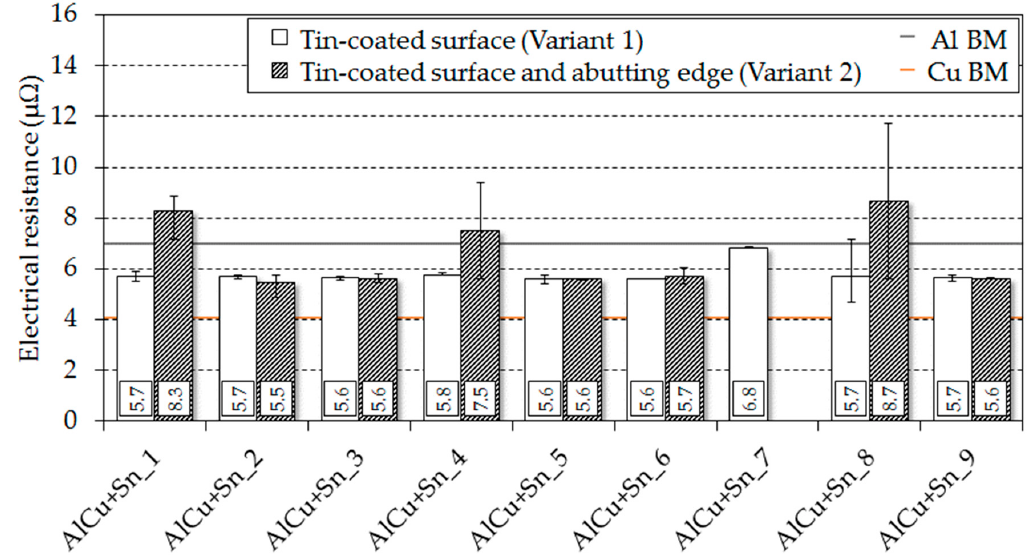
Figure 3. Results of electrical resistance measurements for the friction stir welds produced using aluminum and tinned copper blanks.